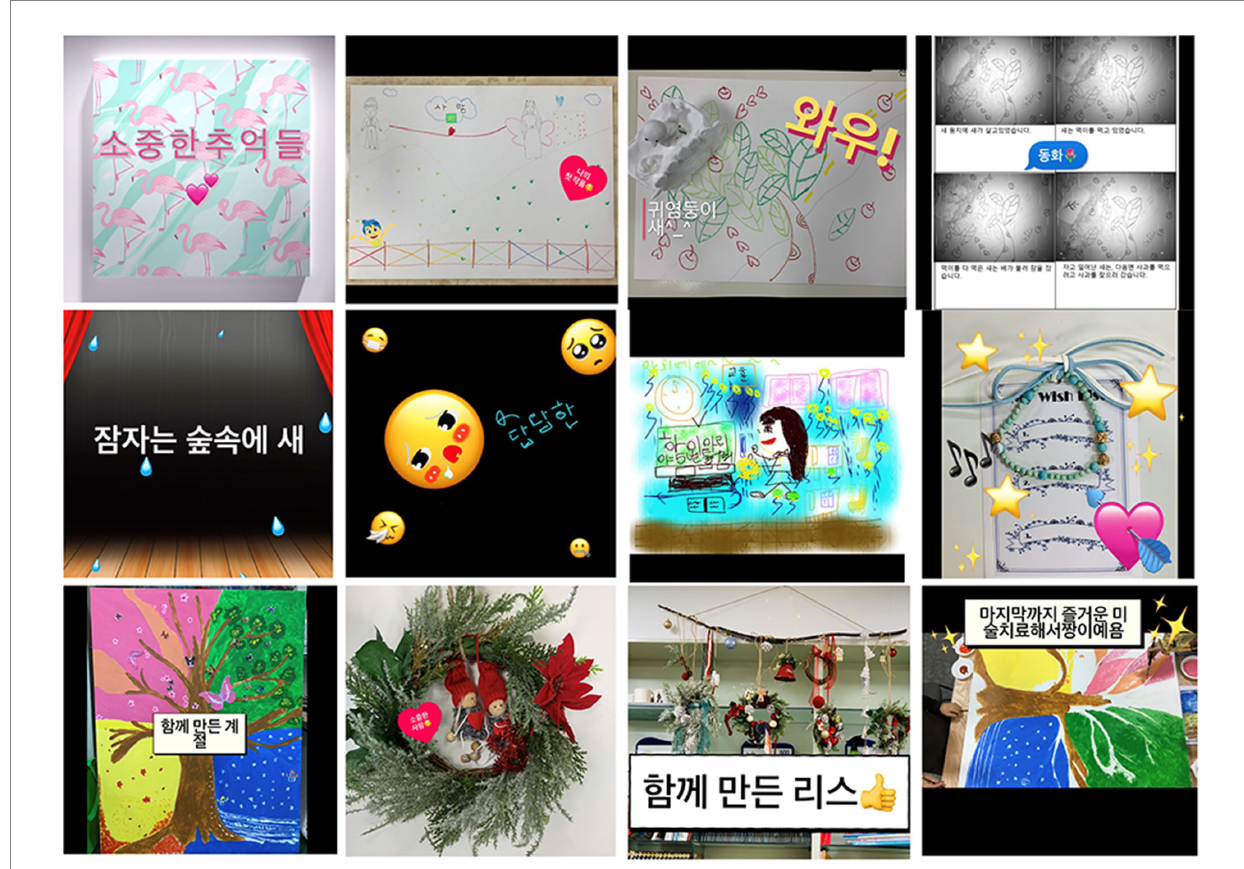
FIGURE 13 Summer’s “Precious memories” (Media art journal video). Soundtrack: Itsudemo by Asuka Ito (Genre: